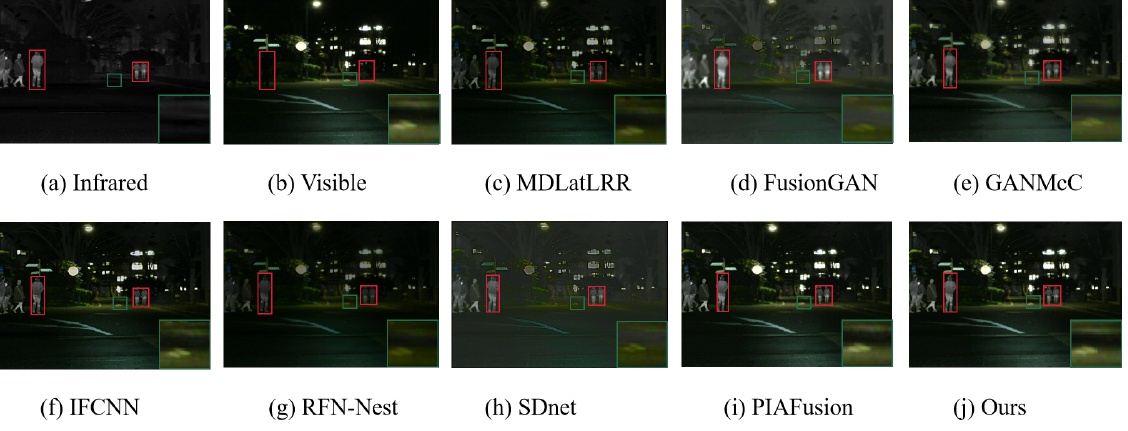
Figure 6. Comparative experiment for different fusion network of a typical nighttime sample from the MSRS